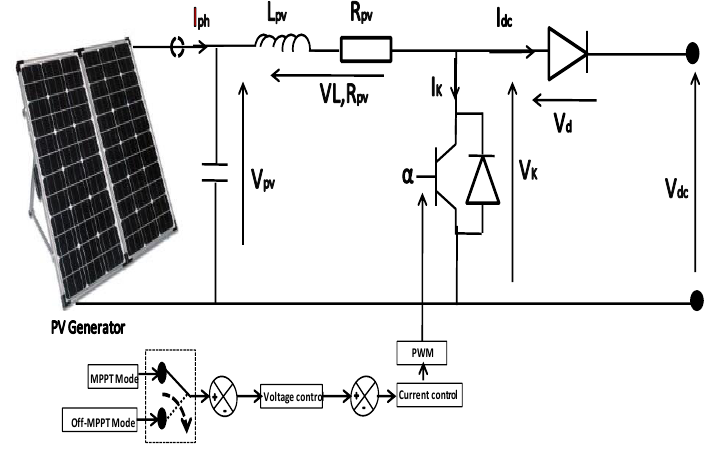
Figure 8. Boost converter for PV generator with both control modes.